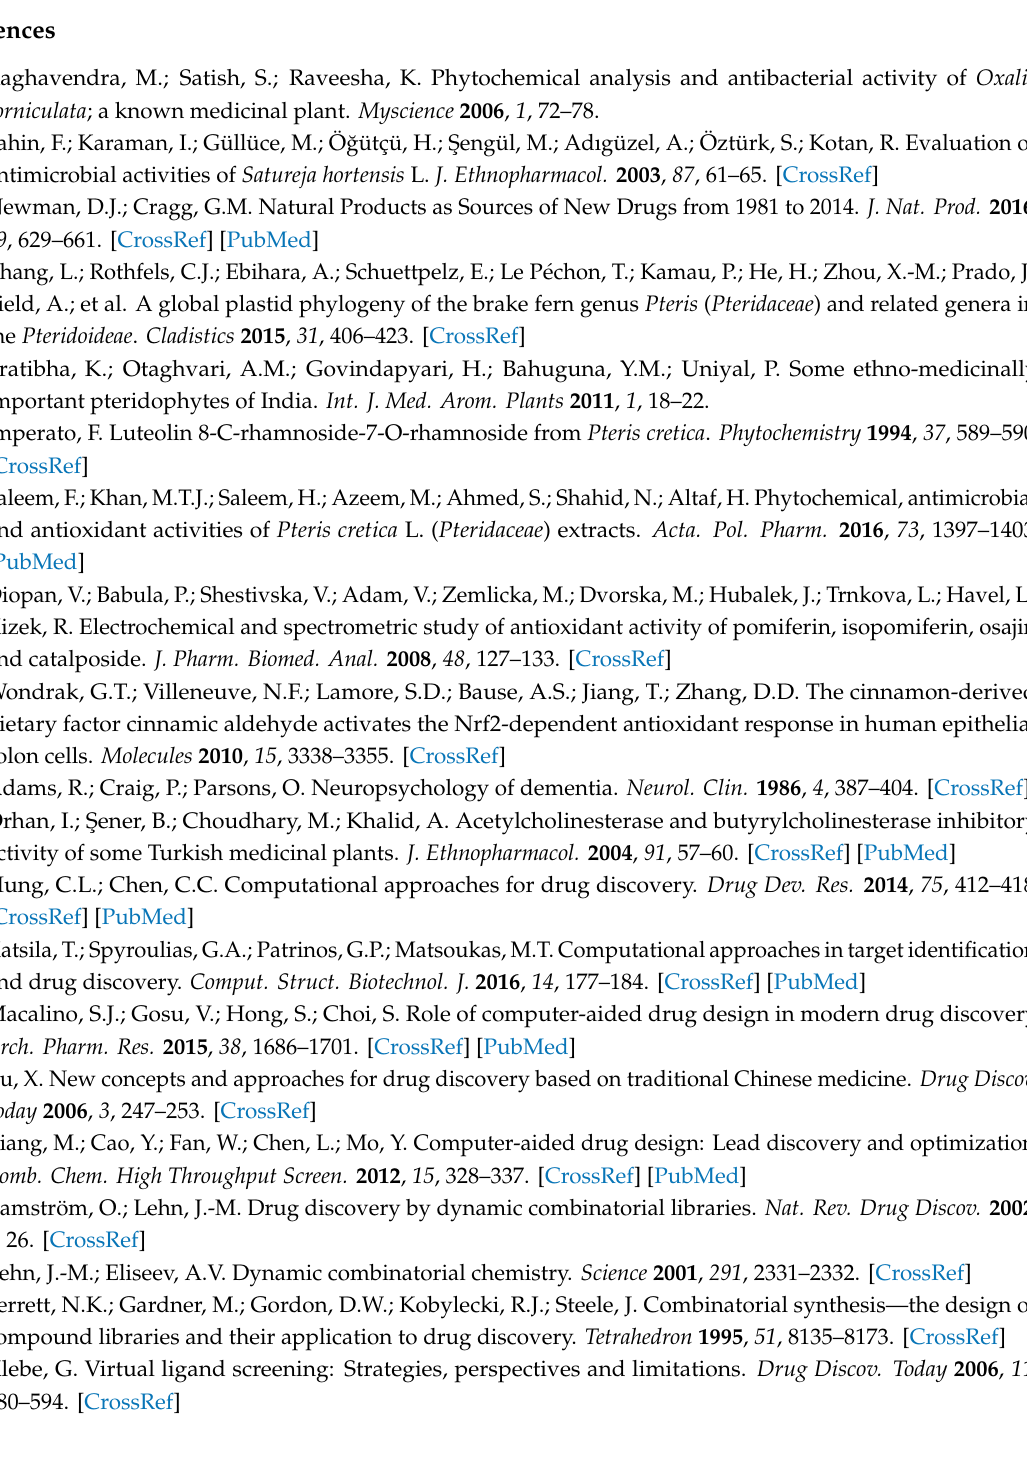
Table S1. Detailed absorption, distribution, metabolism, toxicity and excretion in silico